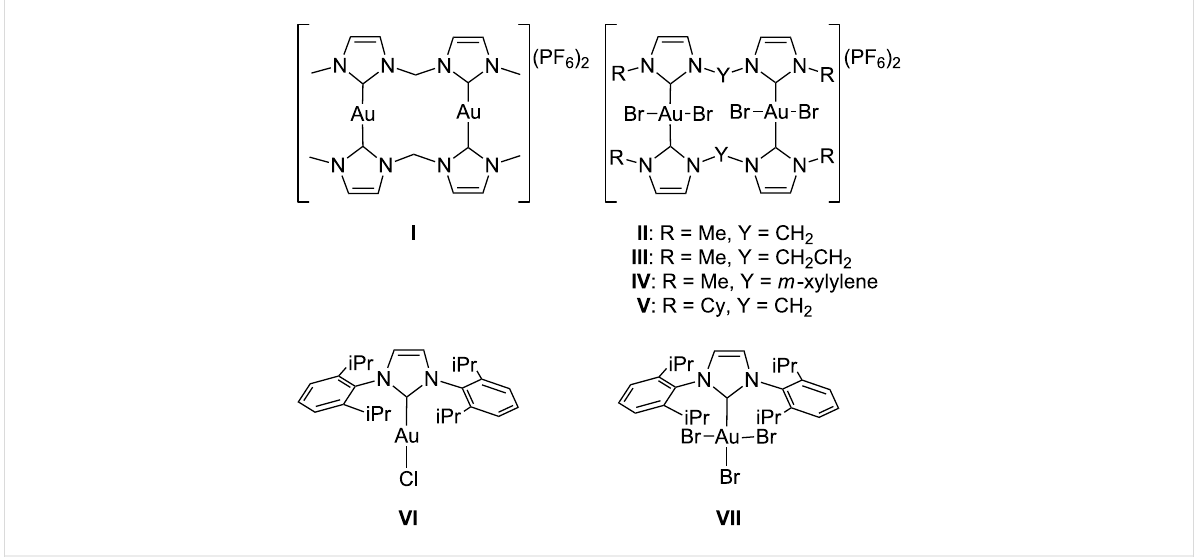
Figure 1: Gold(I) and gold(III) NHC complexes employed as catalysts in this